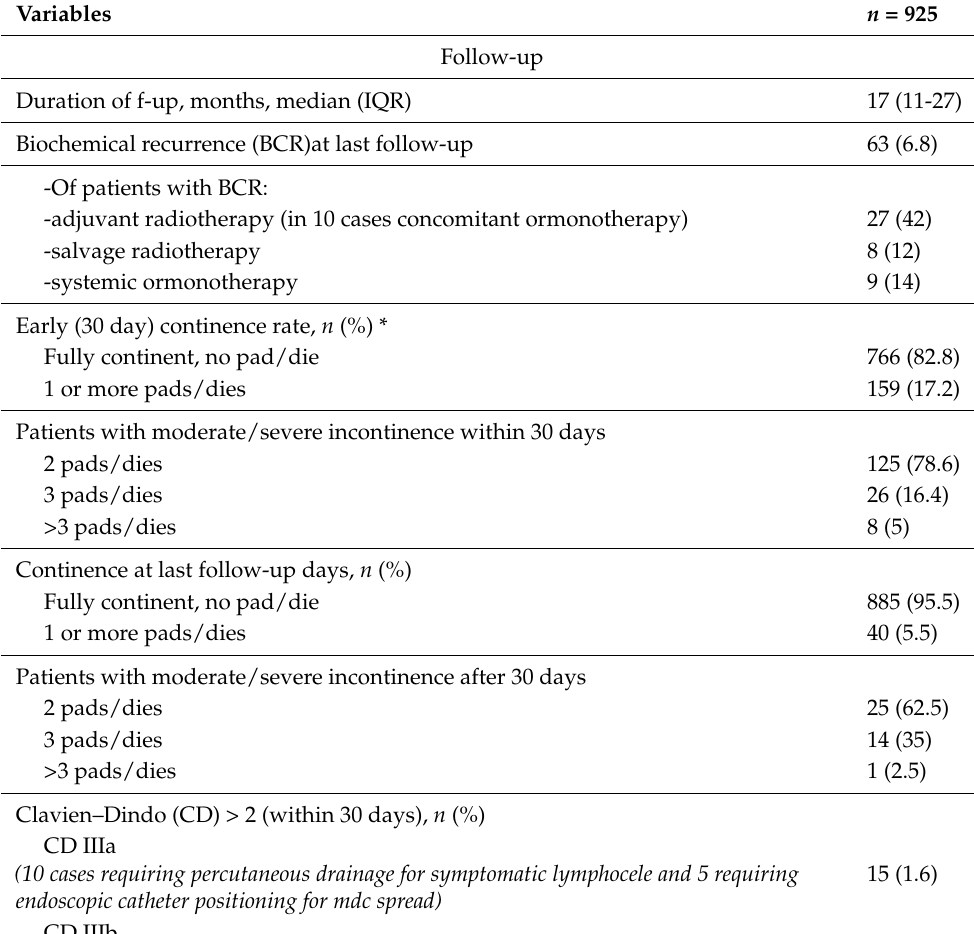
Table 3. Post-operative outcomes and UI outcomes at both short- and mid-term follow-up.